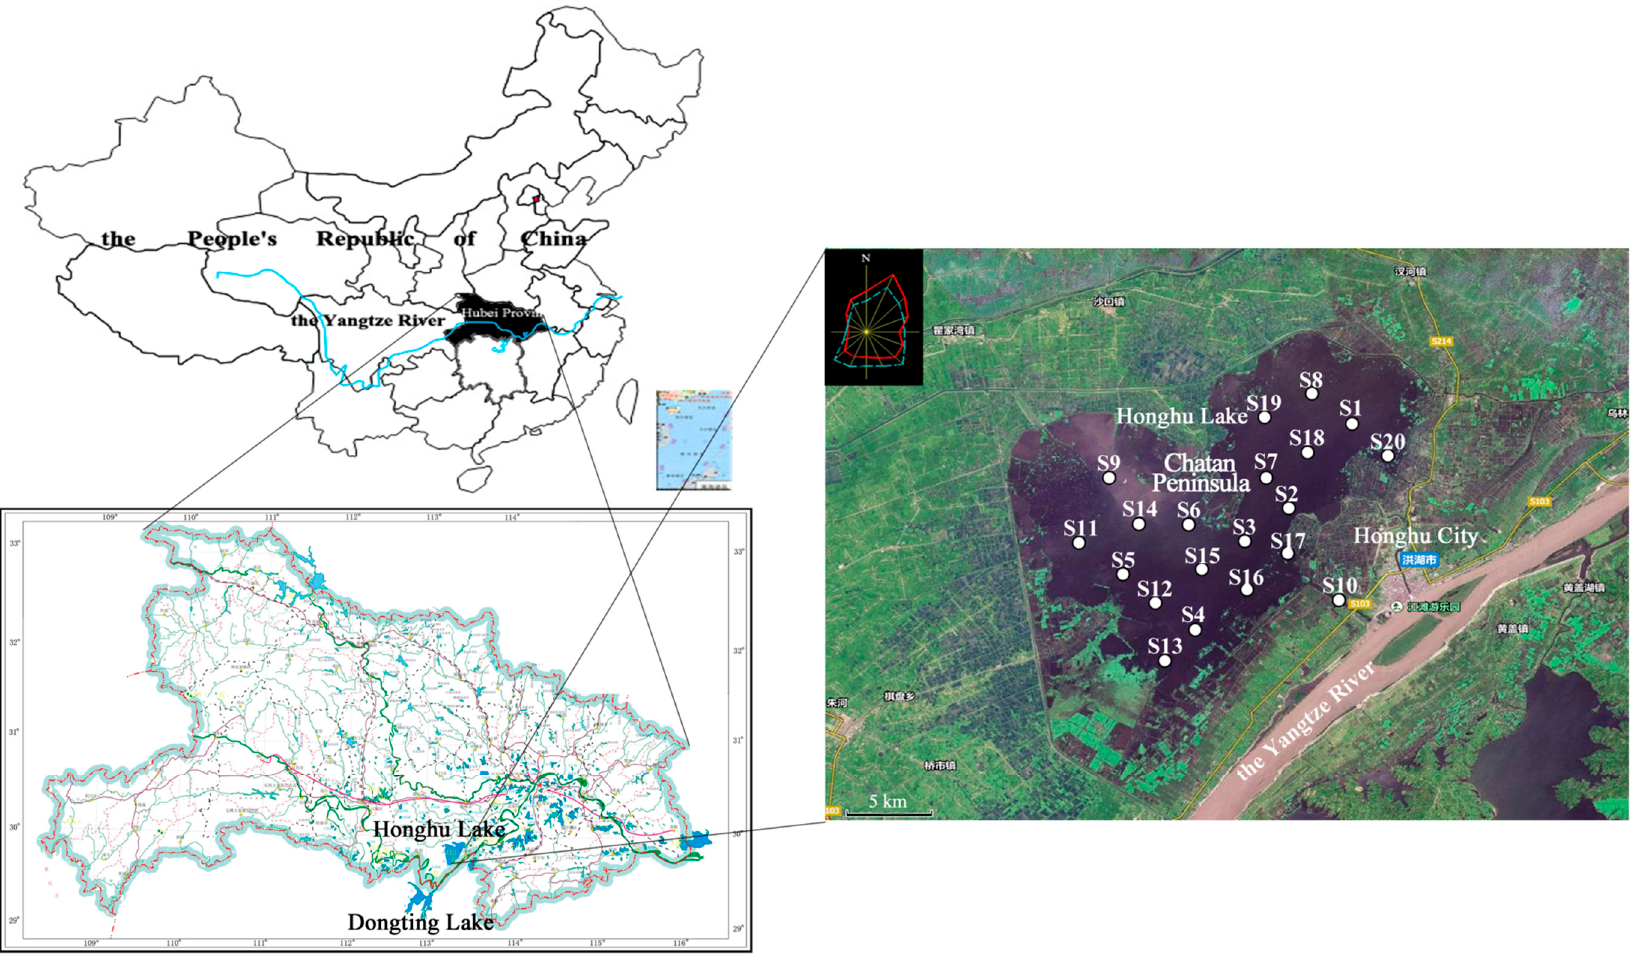
Figure 1. Map of surface water sampling sites in Honghu Lake.